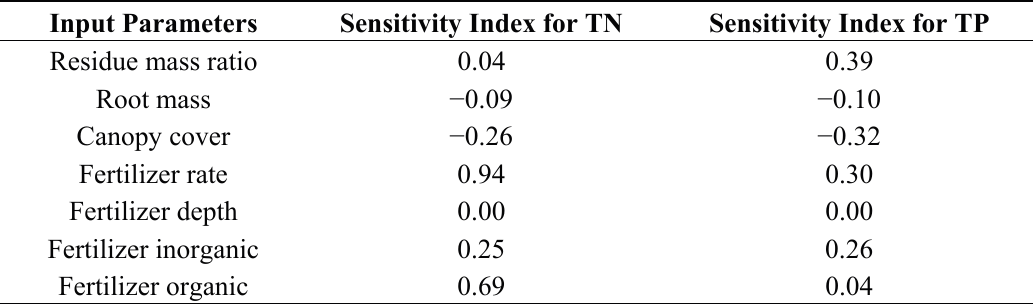
Table 5. Sensitivity classification of AnnAGNPS input parameters to nutrient